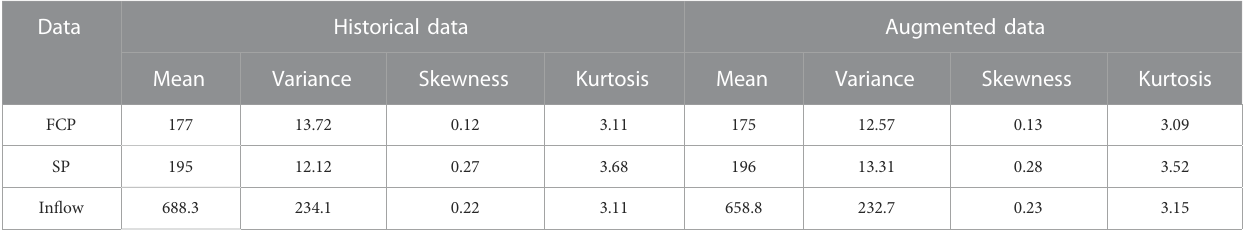
TABLE 2 Statistical indicators of historical data and simulated